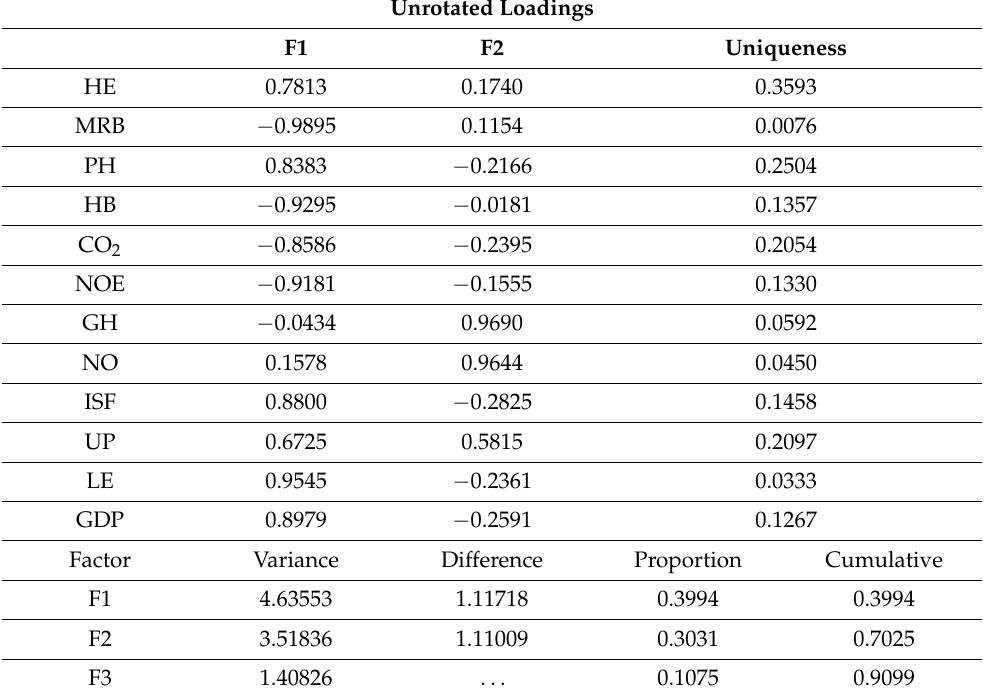
Table 3. Factor loading and explained